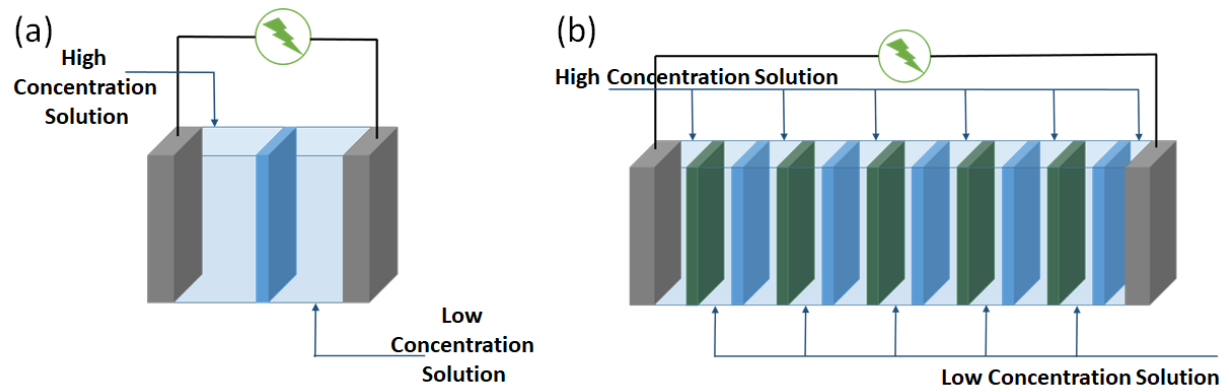
Figure 1. Schematic representation of ( a ) the half ‐ cell system, ( b ) the RED stack, i.e., the full ‐ cell